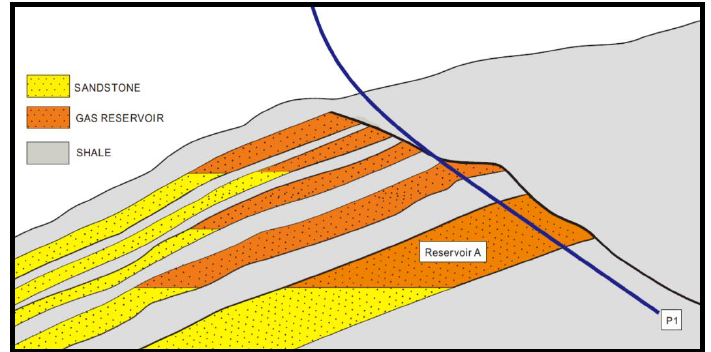
Figure 1. Schematic diagram of the gas reservoir with a target well (modified from Korea National Oil Corporation (KNOC) [26]).